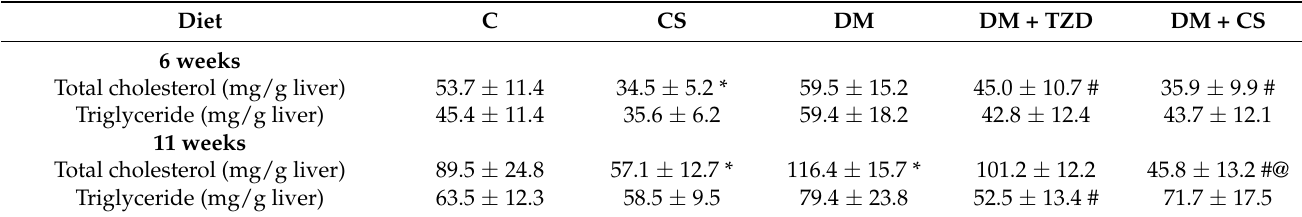
Results are expressed as mean ± SD for each group (n = 8). The significant difference ( p < 0.05) was analyzed by one-way ANOVA and two- tailed Student’s t -test. *: versus C; #: versus DM; @: versus DM + TZD. C: control diet; CS: control diet + 5% high molecular weight chitosan;